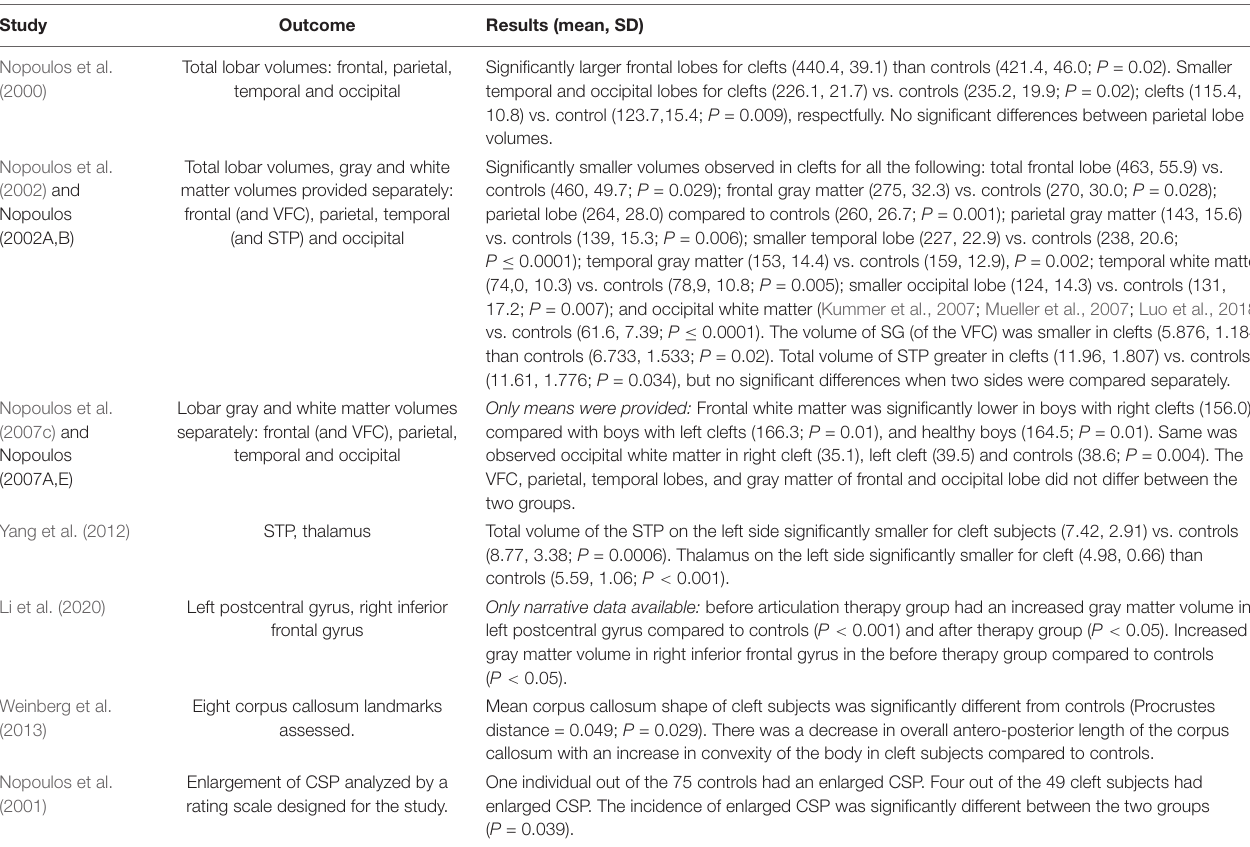
TABLE 3 | Regional